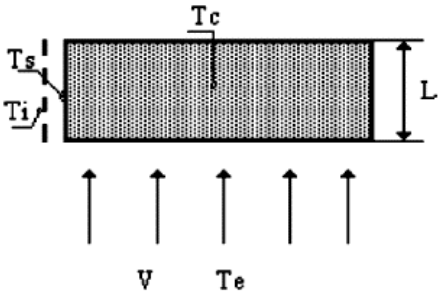
Figure 3. Convection heat transfer for forced flow over a flat plate.